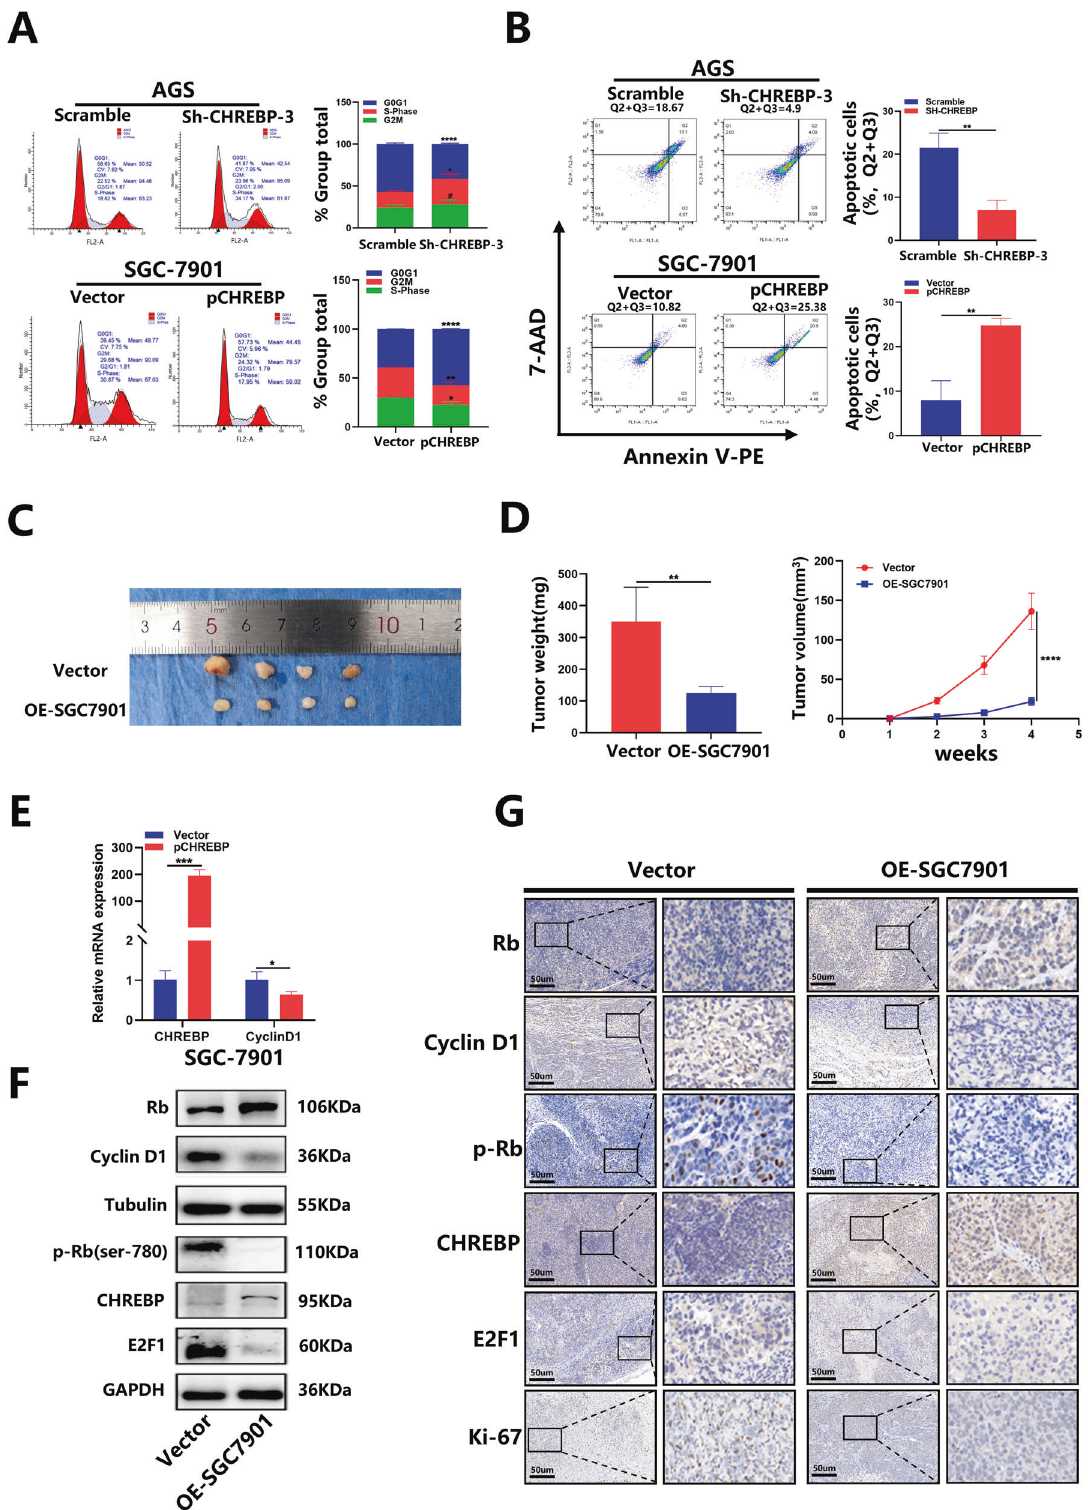
Fig. 4 The effect of CHREBP on GC cell proliferation in vitro and in vivo. A Flow cytometry of AGS and SGC-7901 cells. B The rate of apoptosis of transfected cells was determined by fl ow cytometry (Q2 + Q3). C Images of tumors derived from different group transfected with empty vector and p-CHREBP of nude mice. D Tumors were assessed by their volume and average weight. E, Relative CHREBP and cyclin D1 expression were detected in subcutaneous tumor samples by qRT – PCR. F Relative Rb, cyclin D1, p-Rb (ser-780), CHREBP, and E2F1 expression were measured in subcutaneous tumor samples by WB. G Protein levels of Rb, cyclin D1, p-Rb (ser-780), CHREBP, E2F1, and Ki-67 in tumor samples were determined by IHC (scale bar: 50 μ m). Data are shown as the mean ± SD in triplicate.